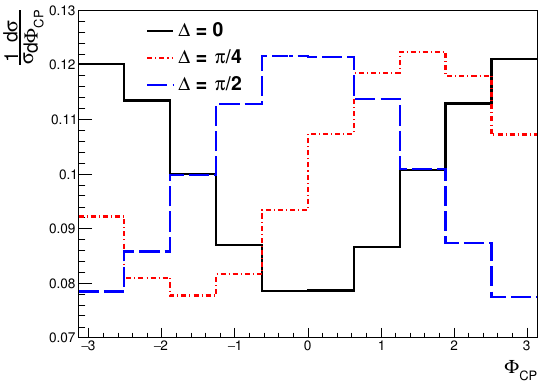
Figure 1 . Normalized di(cid:11)erential distribution of (cid:8) CP for the signal process of h + (cid:21) 2 (cid:0) jets at the 14 TeV LHC, for three di(cid:11)erent values of the CP-mixing angle, (cid:1) = 0 (black solid), (cid:25)= 2 (blue dashed) and (cid:25)= 4 (red dot-dashed). (cid:8) CP is de(cid:12)ned in terms of the momentum vectors of the charged and neutral pions in the (cid:25) + (cid:25) (cid:0) zero momentum frame (eq. (2.4)). The distributions here are shown after the basic and VBF cuts, before folding in the detector